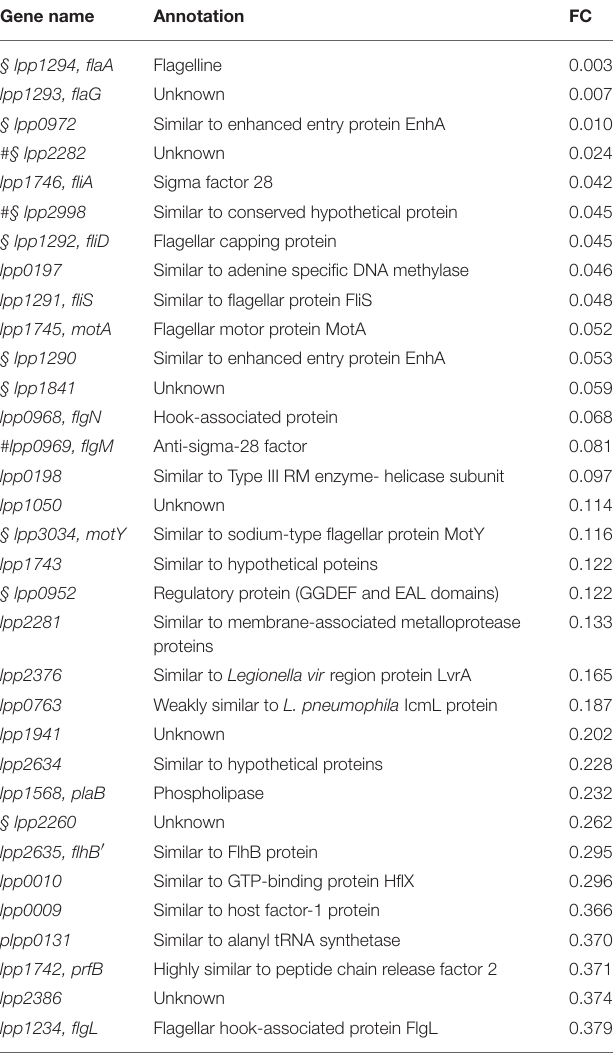
TABLE 1 | Genes belonging to the FliA regulon (FliA target genes) of L. pneumophila Paris